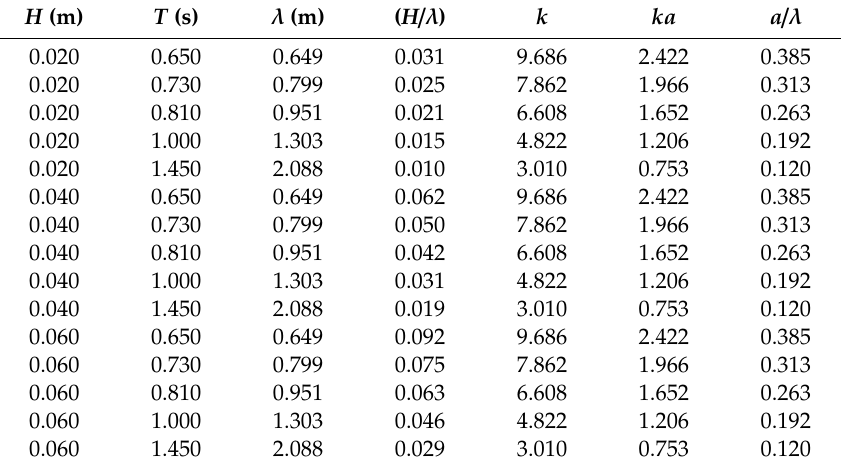
Table 2. Characteristics of generating waves (depth of water a = 0.25